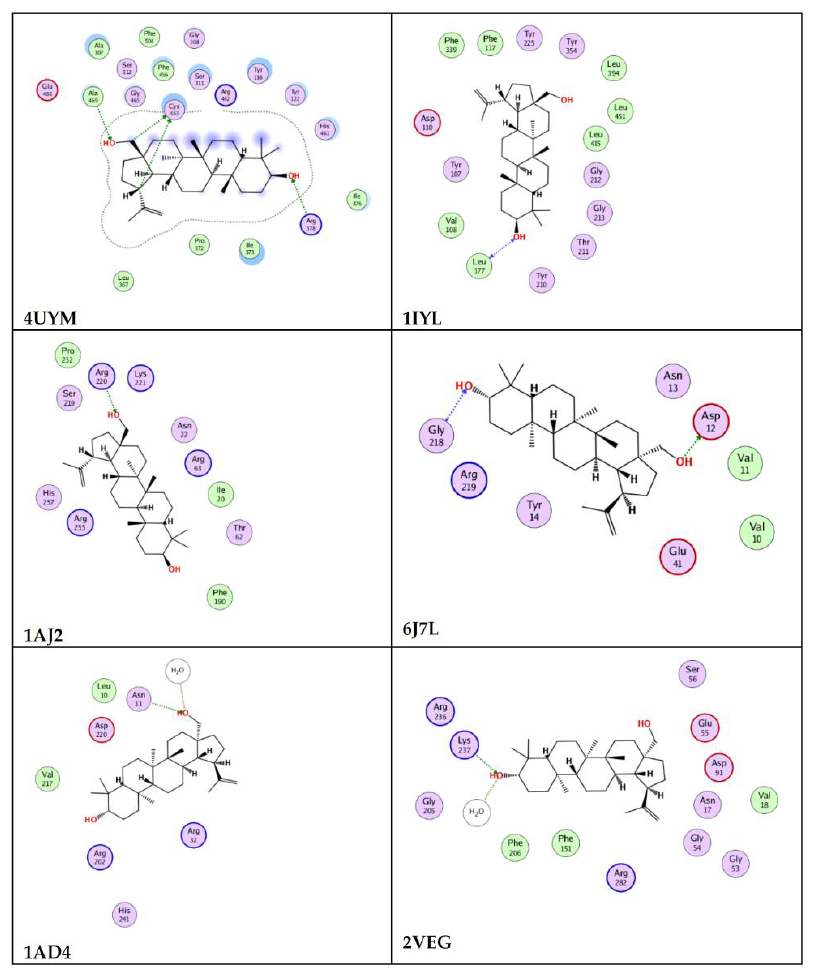
Figure 3. Interaction of 4UYM, 1IYL, 1AJ2, 6J7L, 1AD4, and 2VEG proteins with ligand betulin.